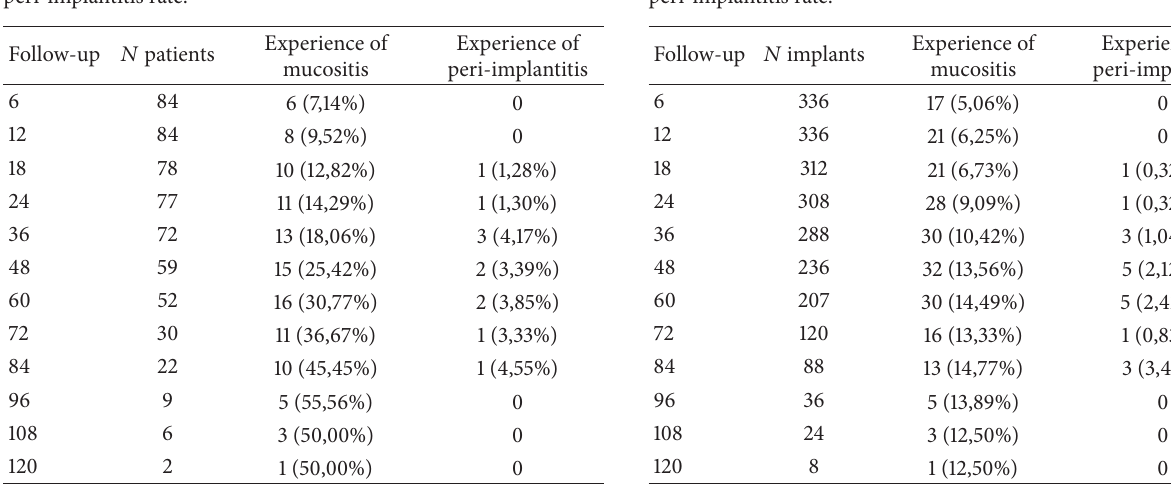
Table 6: Patient-related experience of peri-implant mucositis and peri-implantitis rate.